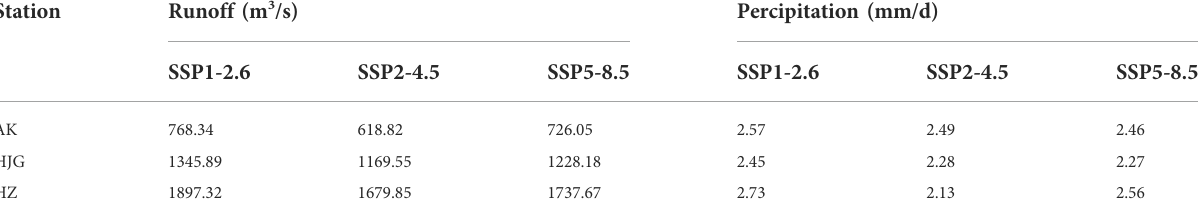
TABLE 4 Average runoff and rainfall of three sections under three